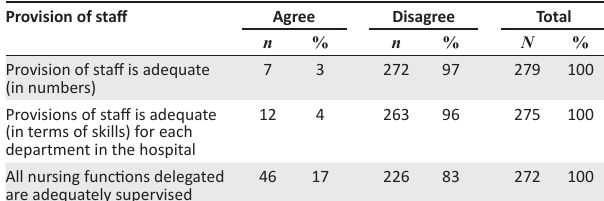
TABLE 1: Provision of staff.